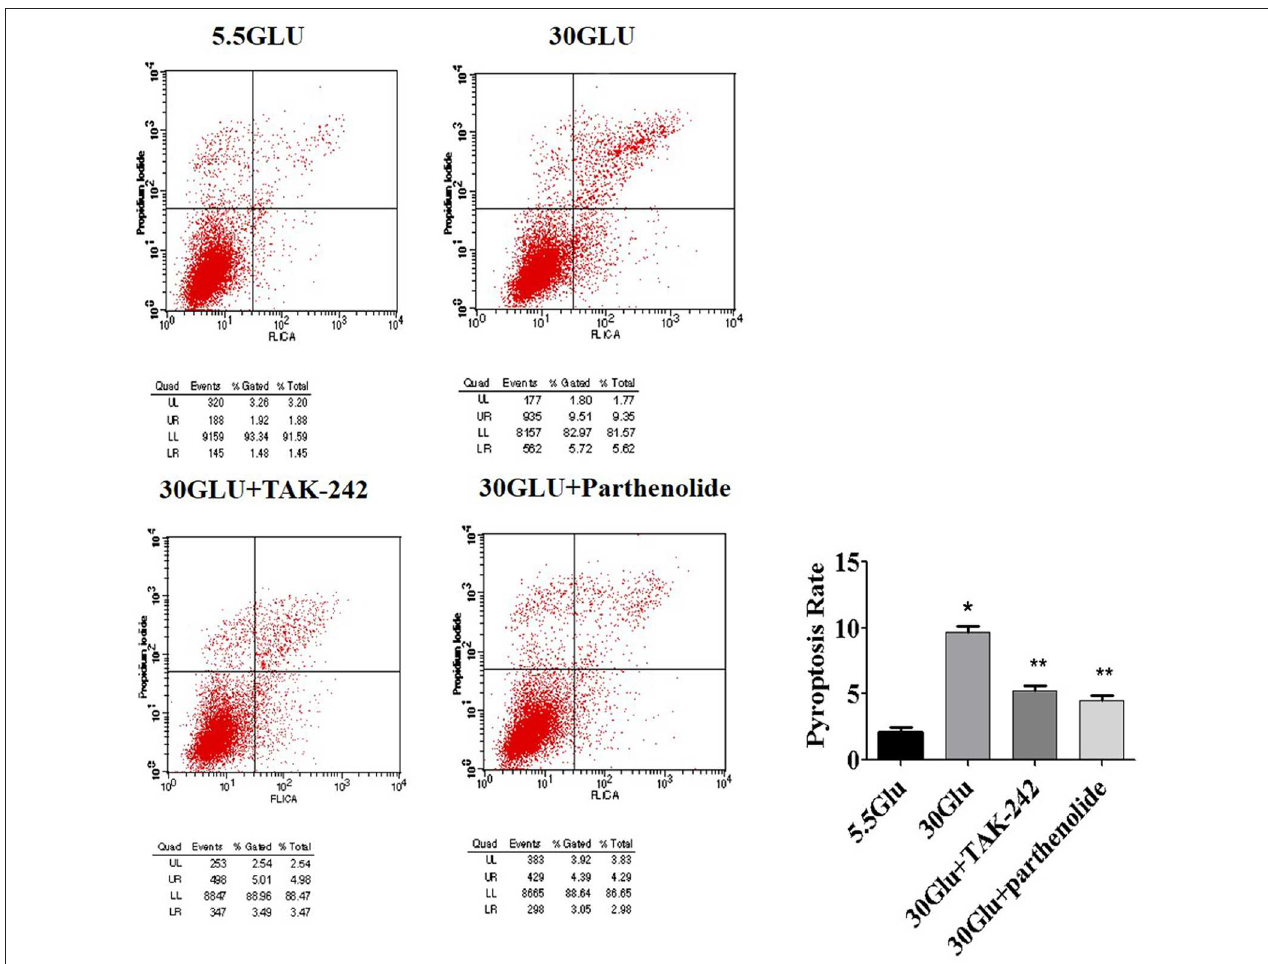
FIGURE 5 | Inhibition of TLR4/NF- κ B signaling reversed pyroptosis in HK-2 cells under HG ambience. Right upper quadrant presented pyroptosis of HK-2 cells, flow cyometry analysis show high glucose (9.35%) increased HK-2 cells pyroptosis significantly compared to the control (1.88%), and was reversed both in 30GLU + TAK242 (4.98%) and 30GLU + parthenolide groups (4.29%). Each assay was representative of three independent experiments. Data were expressed as means ± SEM. (* P < 0.05 vs. 5.5Glu group; ** P < 0.05 vs. 30Glu group).